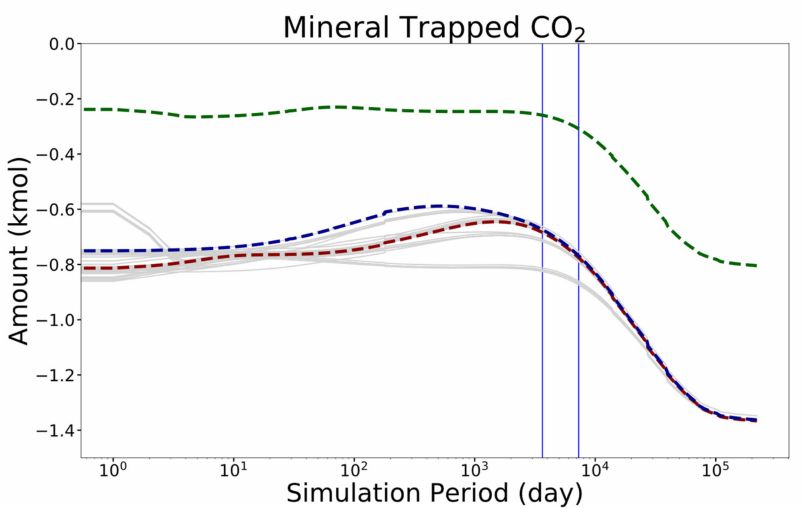
Figure 12. The predicted amount of mineral trapped CO 2 in the simplified 3D model with hydrocar- bons removed. Dashed lines in dark green, dark red, and dark blue indicate Case#86, Case #85, and Case #87, respectively; two vertical lines denote the end of 10 years and the end of 20